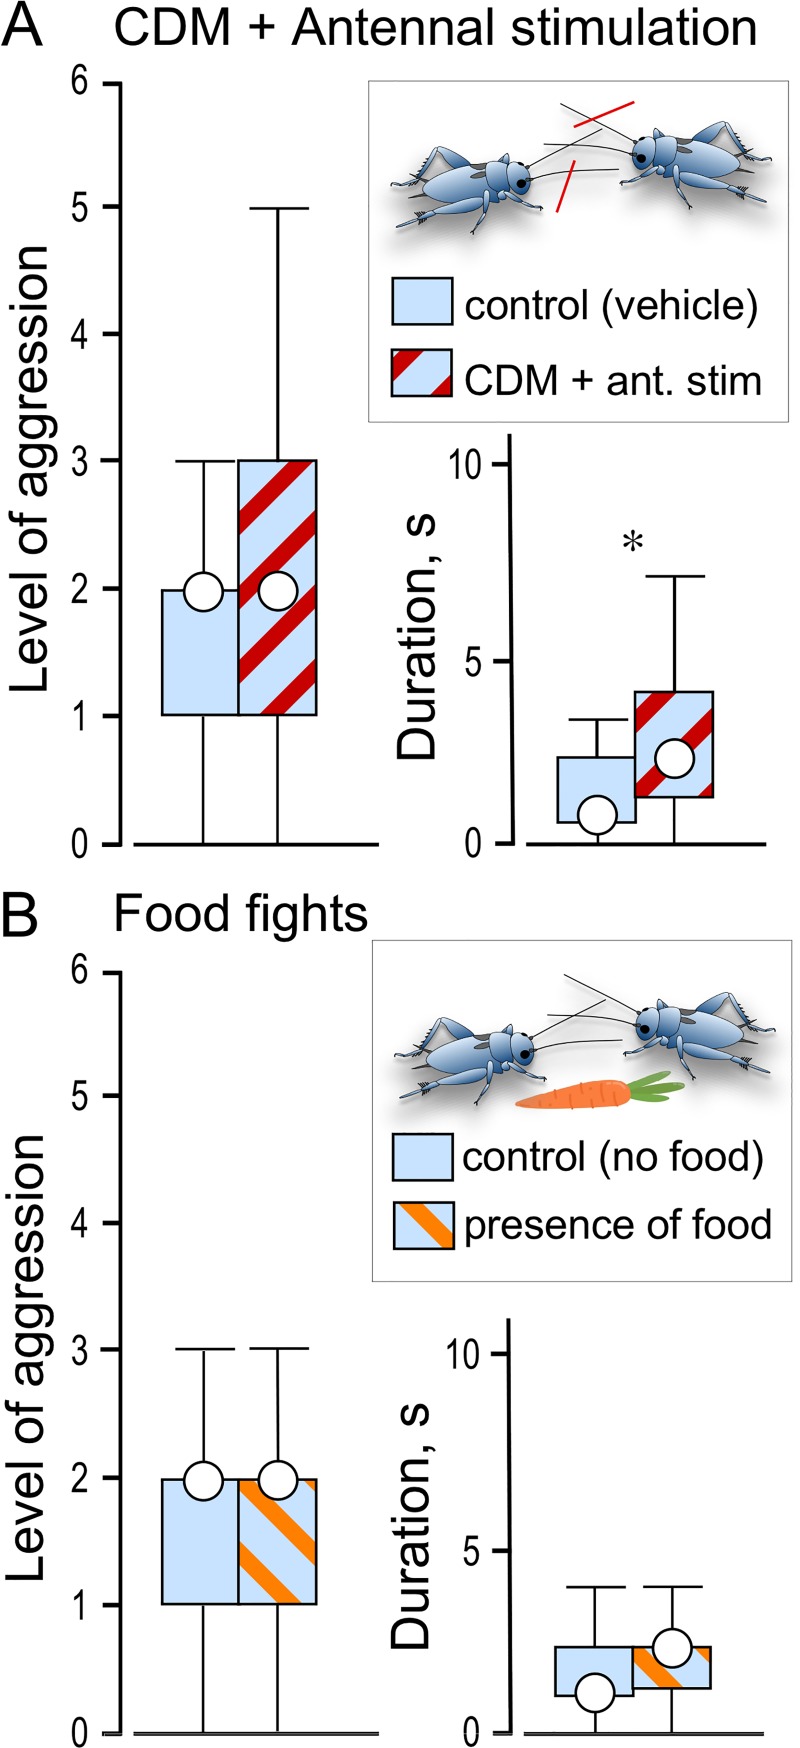
Effects of aggression modulators on aggression in male nymphs.Bars giving the level and duration of agonistic actions between STI male nymphs. (A) After treatment with the octopamine agonist chlordimeform (CDM in 1% DMSO, N = 13) combined with antennal stimulation (red hatched bars). (B) In the presence of food (orange hatched bars, N = 20). Controls (non-hatched bars) received DMSO in saline (A, N = 13) or no food (B, N = 20). Significant differences between unpaired data sets are indicated (Mann-Whitney U test: * p < 0.05).